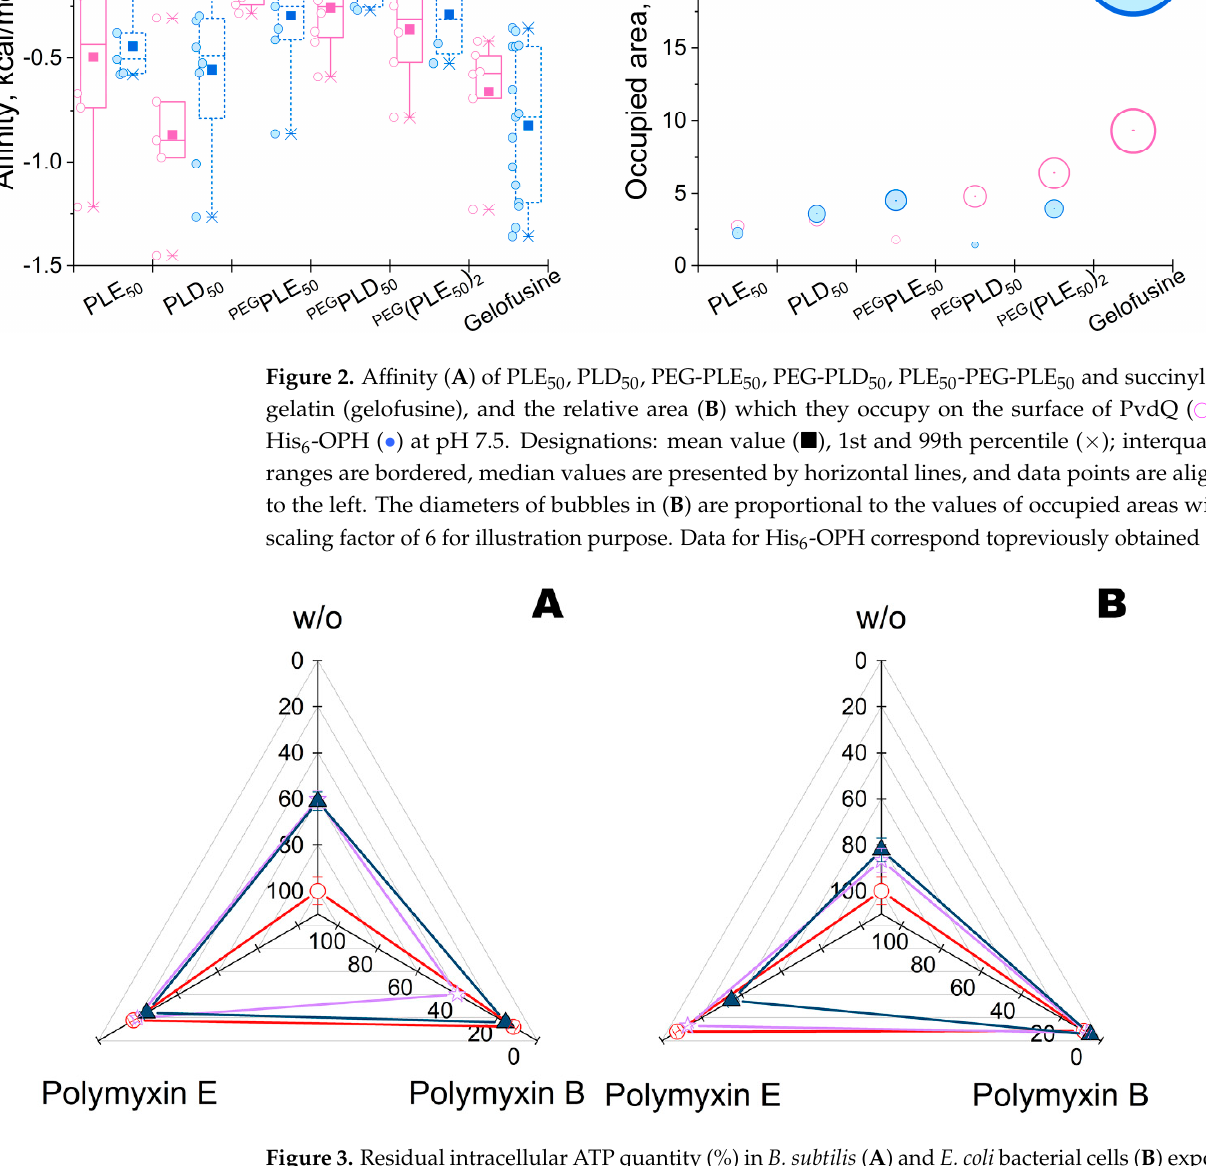
Figure 3. Residual intracellular ATP quantity (%) in B. subtilis ( A ) and E. coli bacterial cells ( B ) ex-